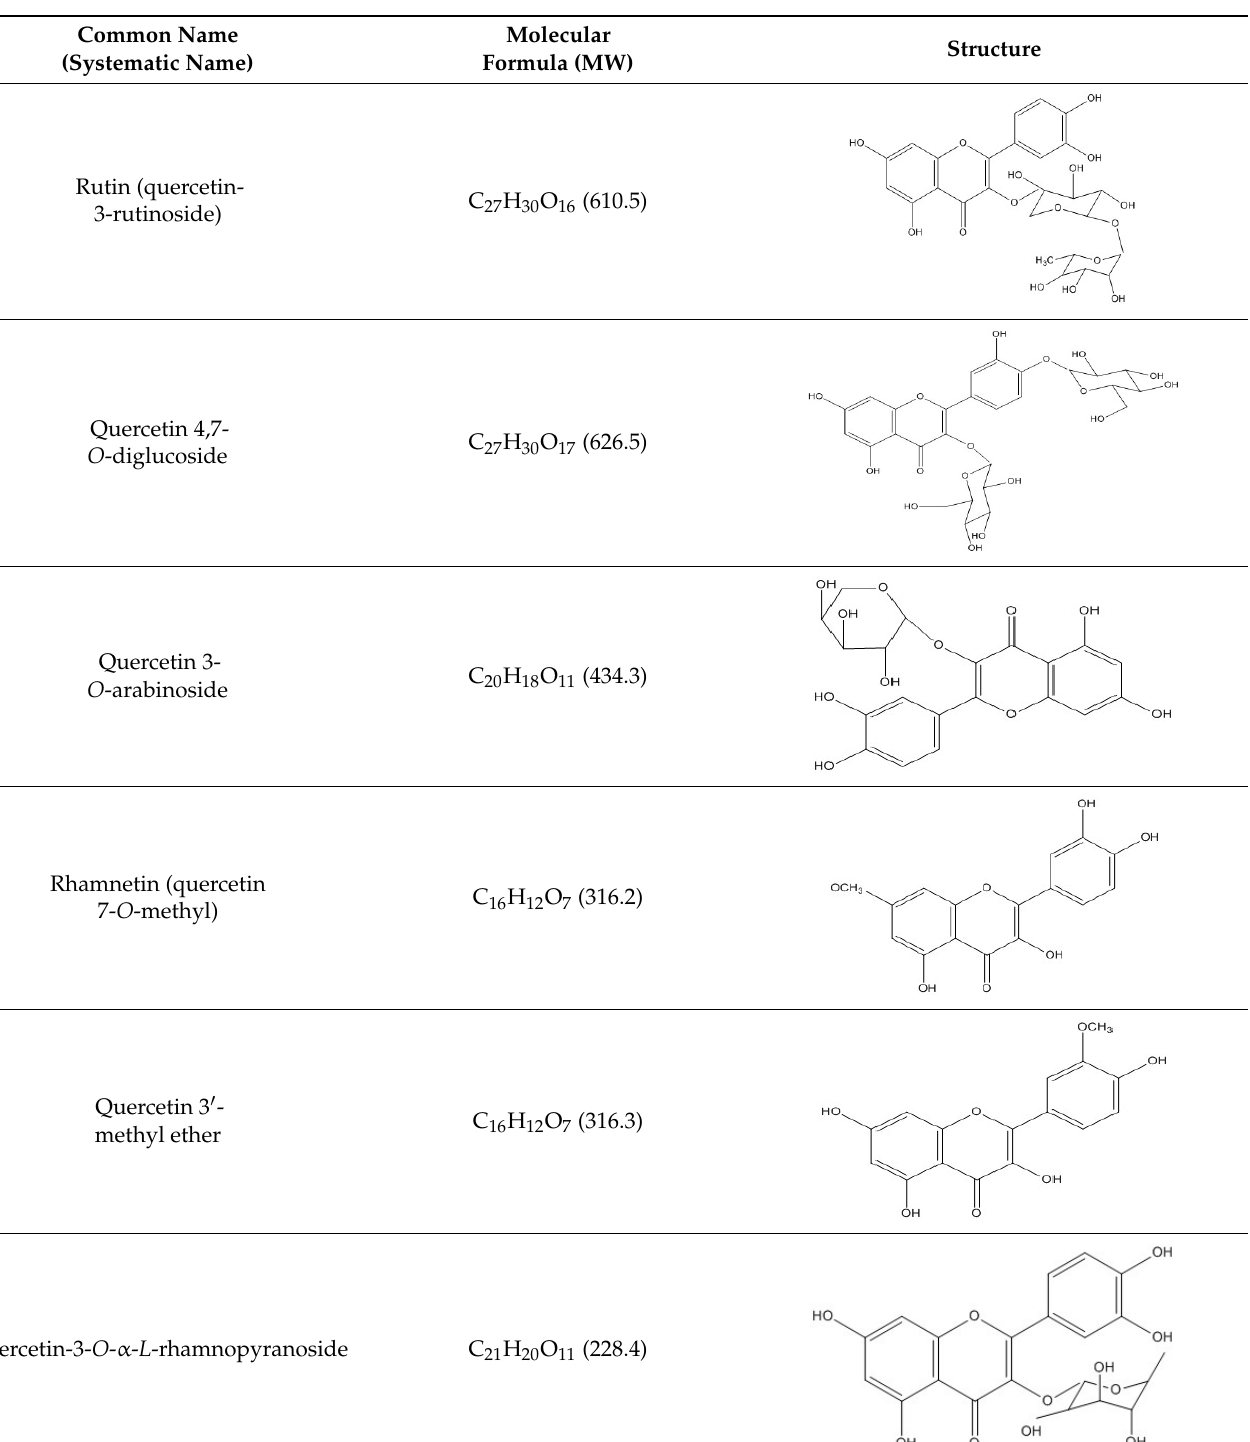
Quercetin-3- O - α - L -rhamnopyranoside